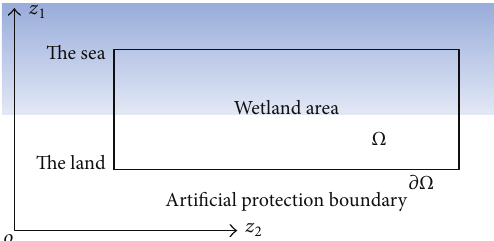
Figure 1: The idealized spatial domain is a rectangular domain with the sea oriented direction 𝑧 1 and coast line direction 𝑧 2 . The wetland conservation is closed with no flux boundary conditions